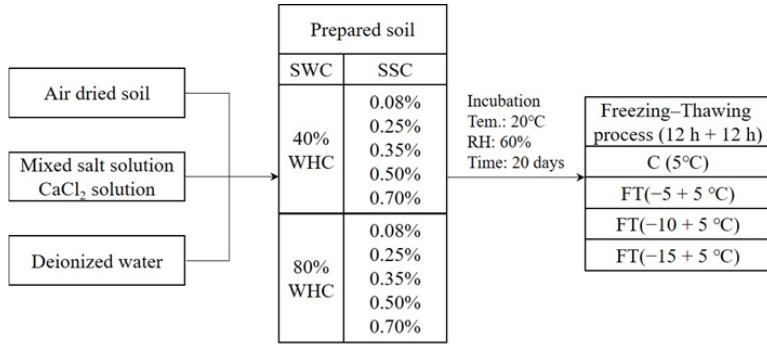
Figure 1. Experimental flow chart.